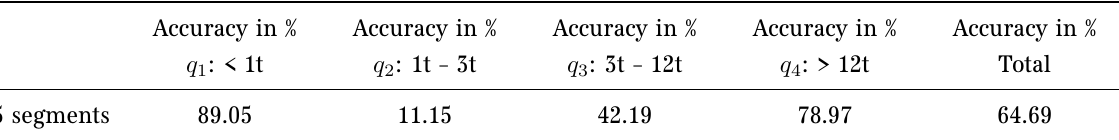
Table 10: Correctly predicted test shipments conditioned on shipment size category for the model with 5